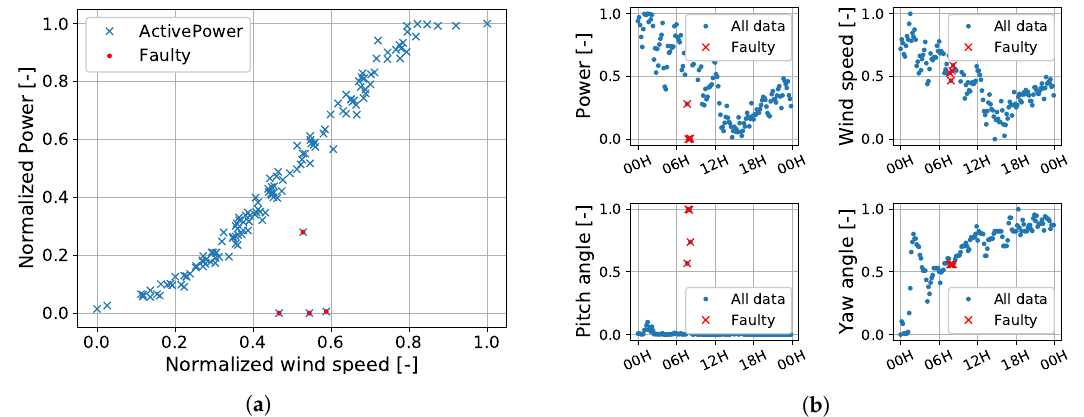
Figure 6. Power curve ( a ) and time series of power, wind speed, pitch angle and yaw angle ( b ) from SCADA measurements for a time period where a problem with blade angle has